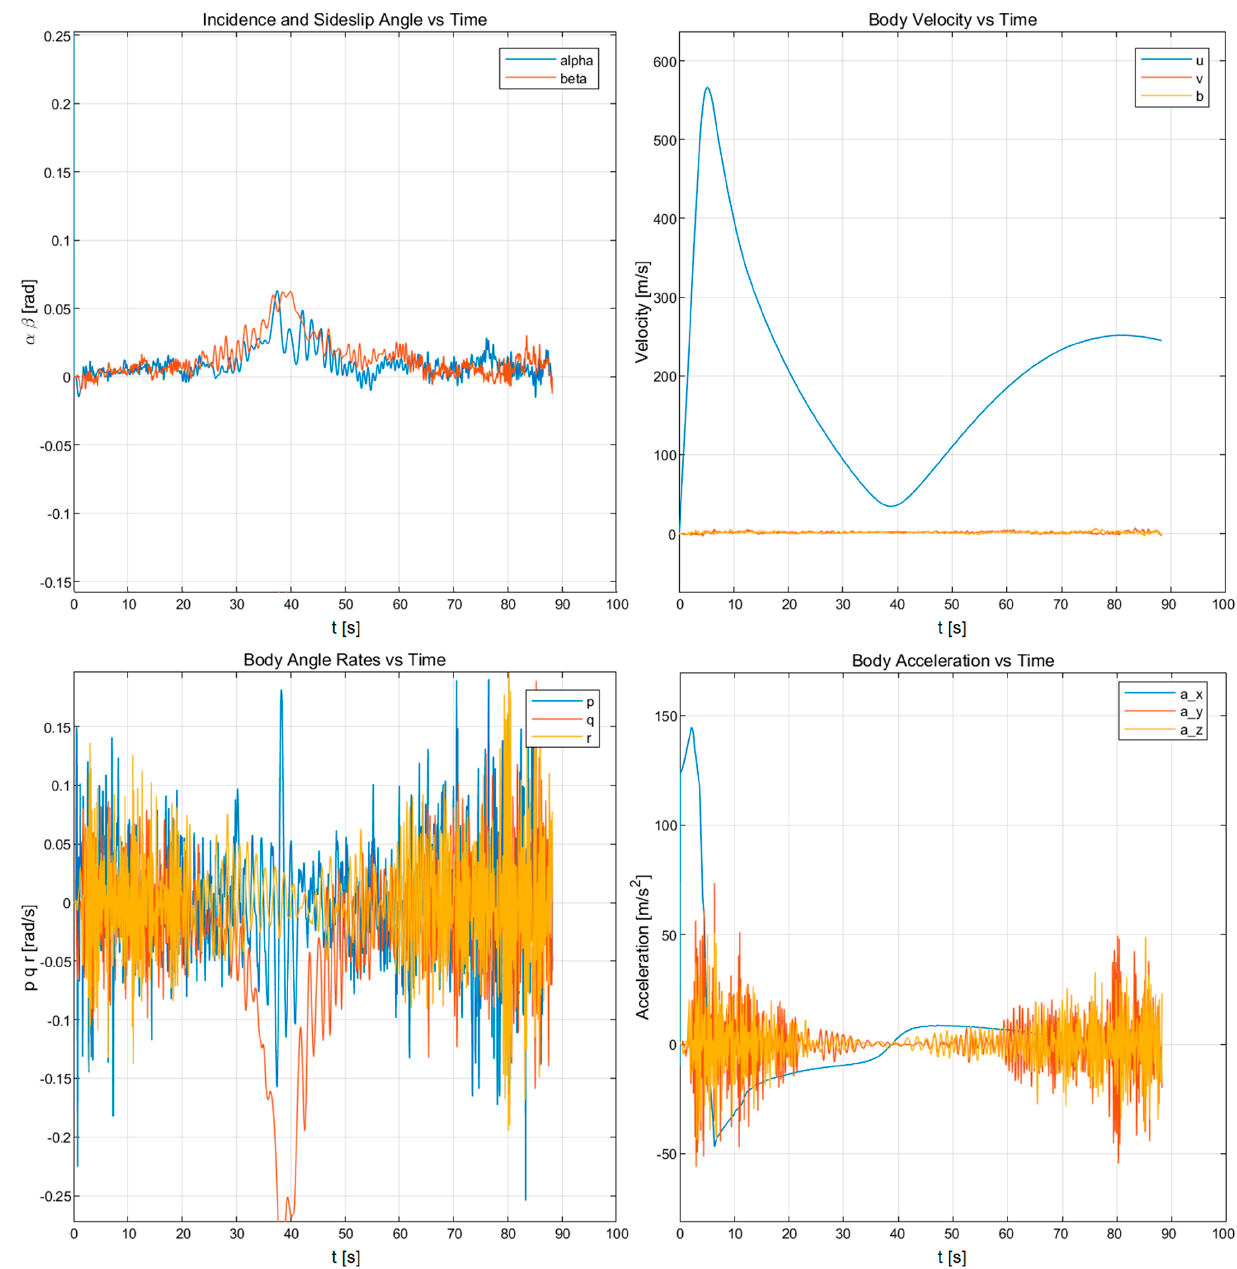
Figure 23. Body axis results.